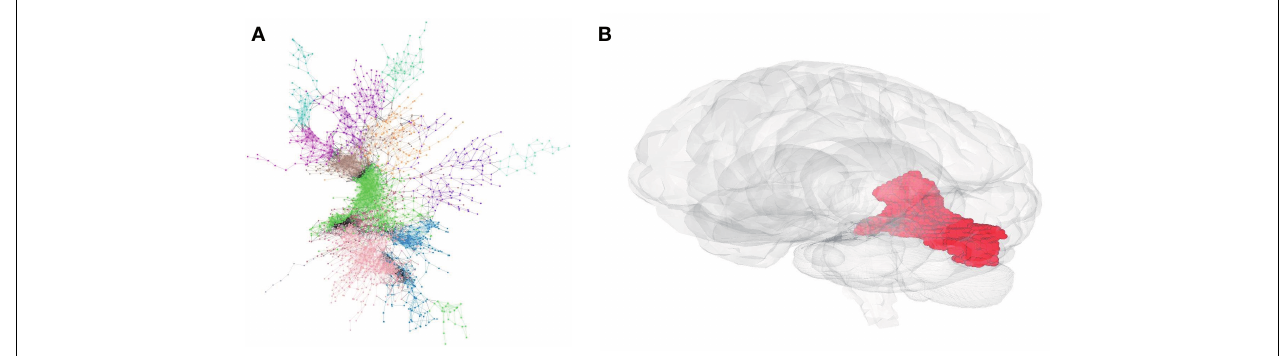
FIGURE 1 | (A) Network representation of a brain cluster, as found by the phase correlation between pairs of voxels. (B) The same cluster in real-space representation, where each voxel is now placed in its known location in the brain.